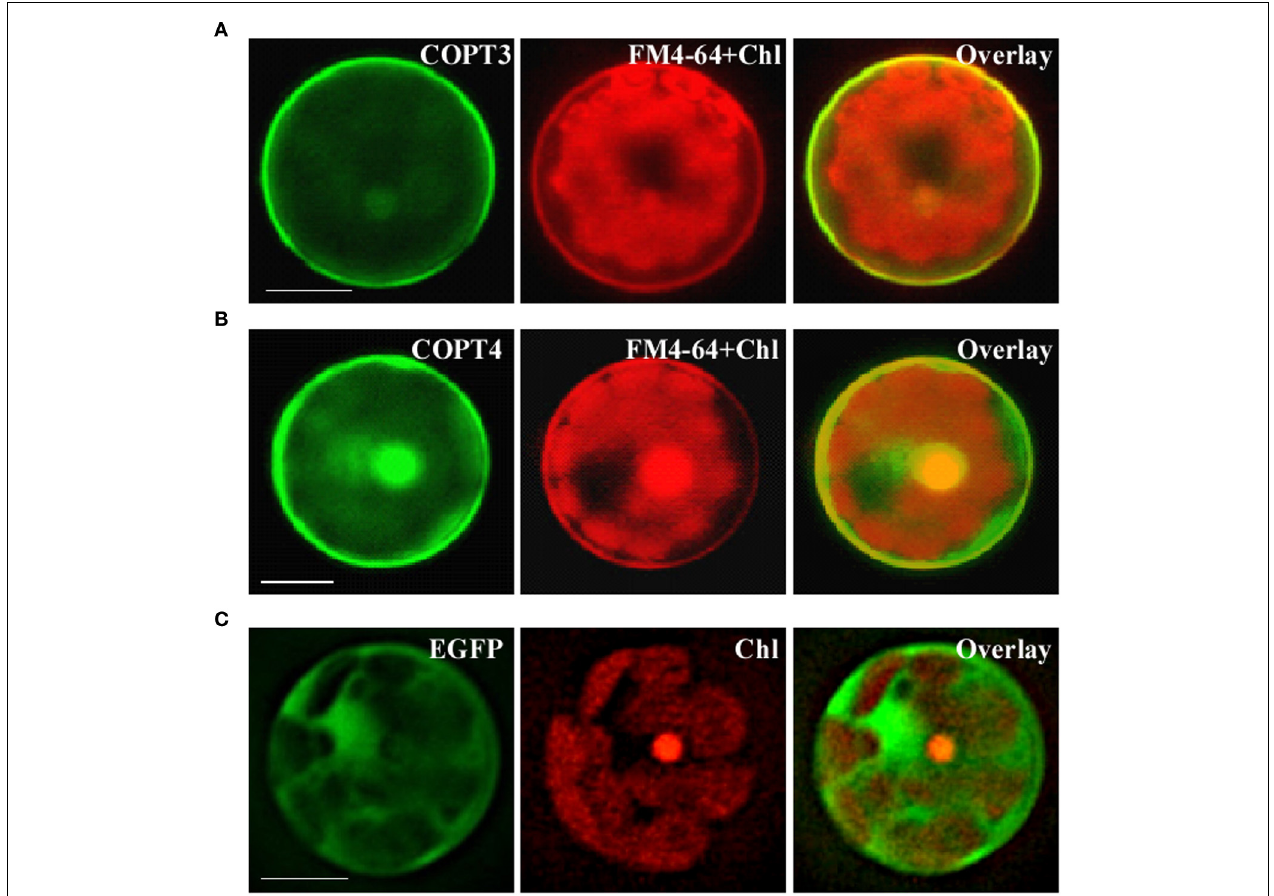
FIGURE 7 | Subcellular localization of BdCOPT3 and BdCOPT4 in brachypodium protoplasts. Protoplasts isolated from leaves of 25-day-old plants were transfected with BdCOPT3-EGFP (A) or BdCOPT4-EGFP (B) constructs or the empty SAT6-N1-EGFP vector (C) and co-stained with the plasma-membrane dye, FM4-64. EGFP-mediated fluorescence derived from BdCOPT3-EGFP (COPT3) or BdCOPT4-EGFP, (COPT4), or from EGFP of the